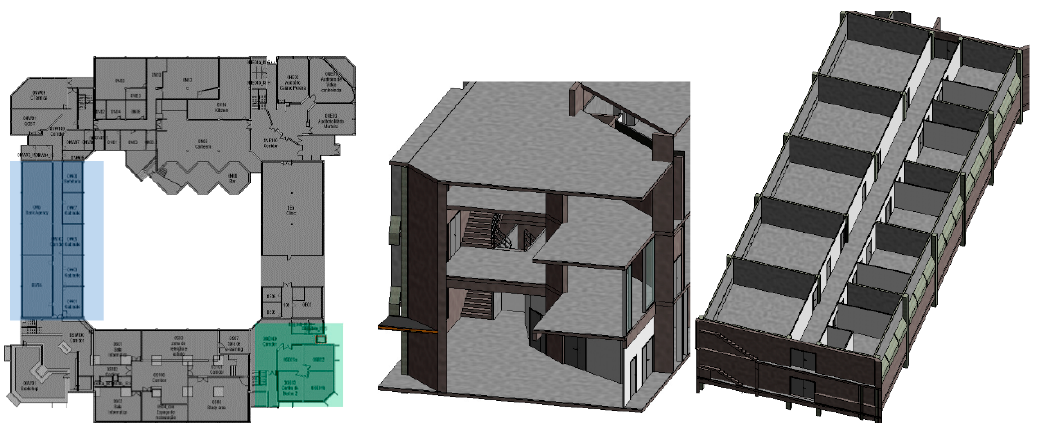
Figure 3. Location of the two signal propagation zones in building floor plan in ISCTE-IUL’s Building 1 ( Left ), the perspective of the mezzanine zone, marked in green ( Middle ) and of the corridor zone, marked in blue ( Right ).